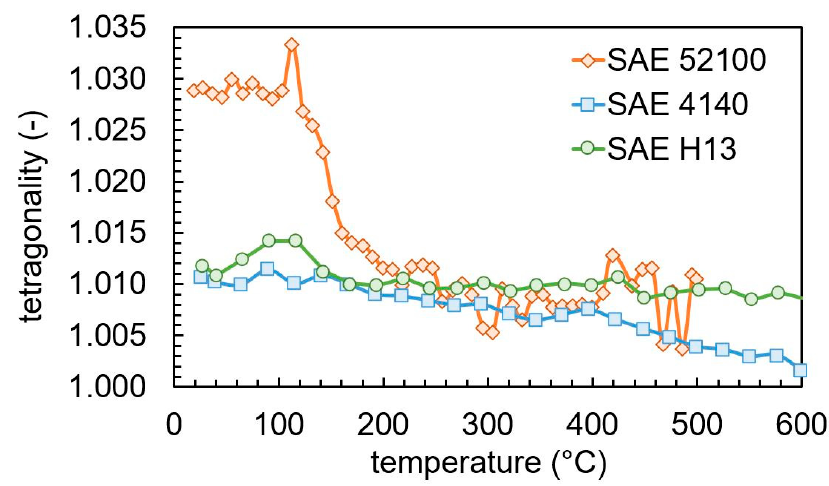
Figure 12. Evolution of martensite tetragonality during tempering.